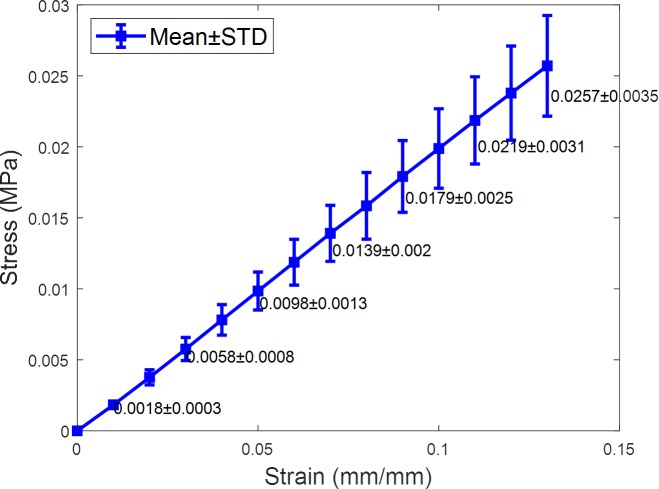
Mean stress-strain curve of 3 hydrogel samples.